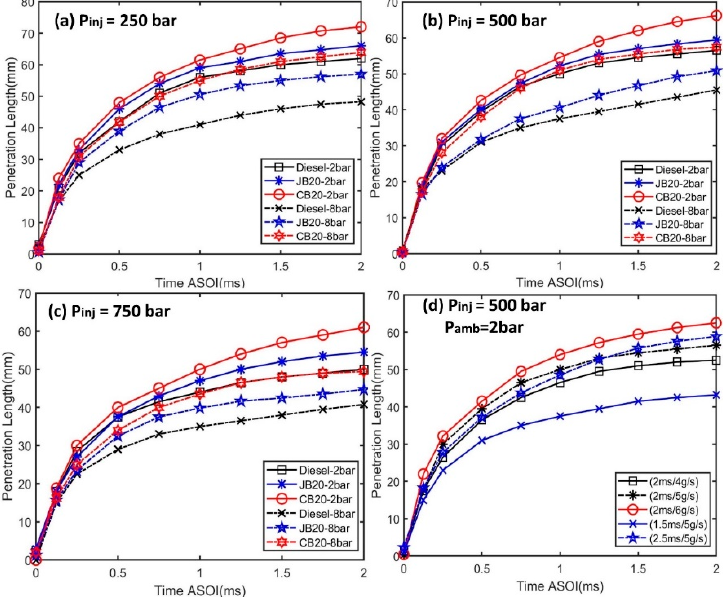
Figure 9. Spray PL at ( a ) 2-bar, ( b ) 5-bar, and ( c ) 8-bar ambient pressures. ( d ) Effect of mass flow rate and injection duration on PL at 500-bar injection and 8-bar ambient pressure for diesel.